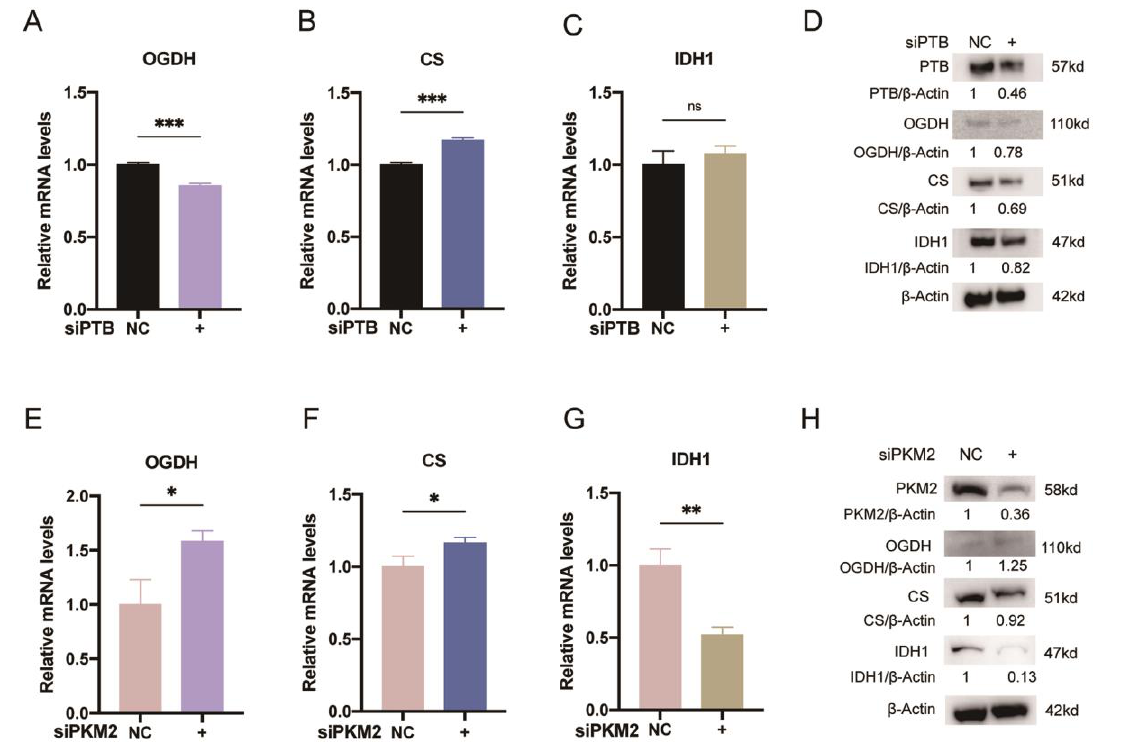
Figure 6. PTB knockdown downregulated the key enzymes of the TCA cycle. qRT-PCR ( A – C ) and Western blot ( D ) analyses of OGDH, CS, and IDH1 were performed after KFb were transfected with siPTB. qRT-PCR ( E – G ) and Western blot ( H ) analyses of OGDH, CS, and IDH1 were performed after KFb were transfected with siPKM2 ( n = 3). Data are presented as the mean ± S.D. * p < 0.05, ** p < 0.01, *** p <